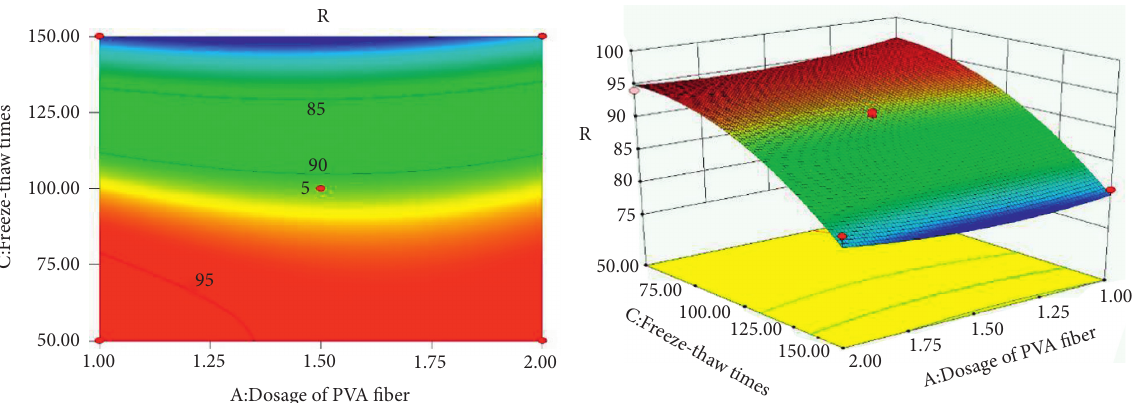
Figure 5: The effect of the interaction of A and C on